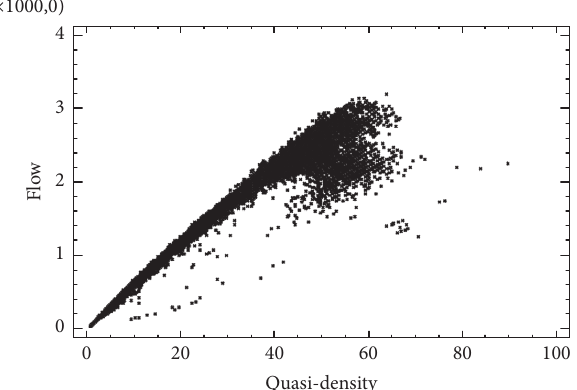
Figure 6: Fundamental diagram; hourly flow (veh/h) against quasi- density (veh/km).